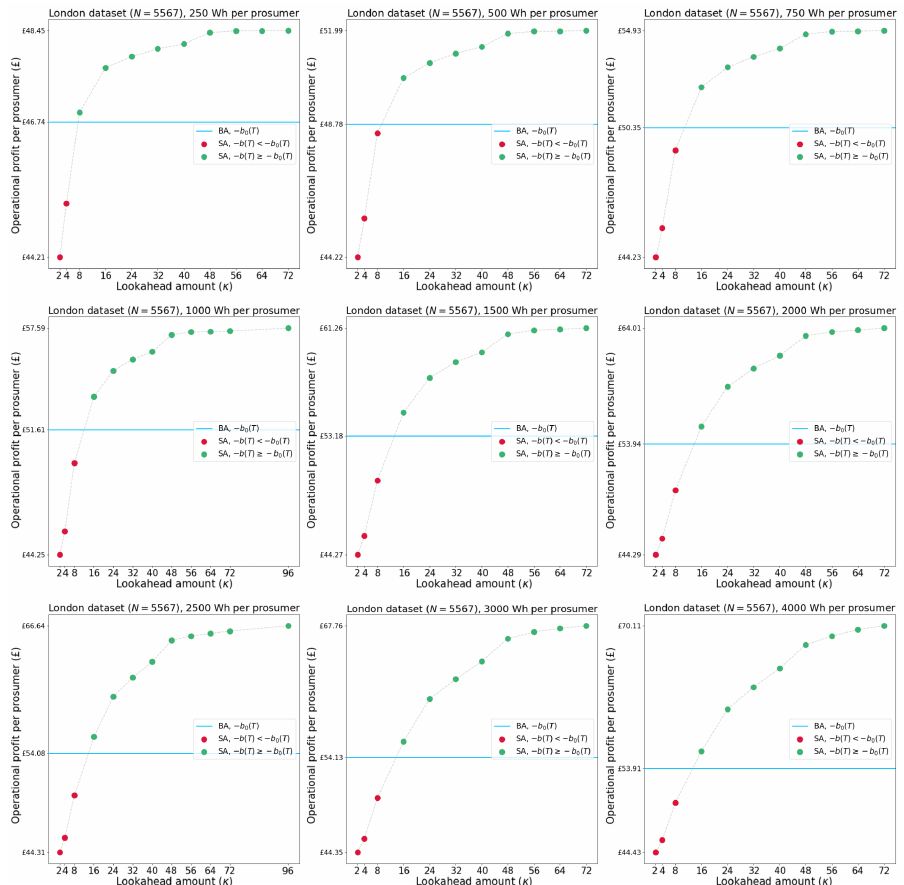
Figure A1. Part 1: Overview of operational profits per prosumer for the baseline and smart battery scheduling algorithm using various sizes for the lookahead window ( κ ) and various sizes for the battery per prosumer ( ω / N ) on original historical data of London.